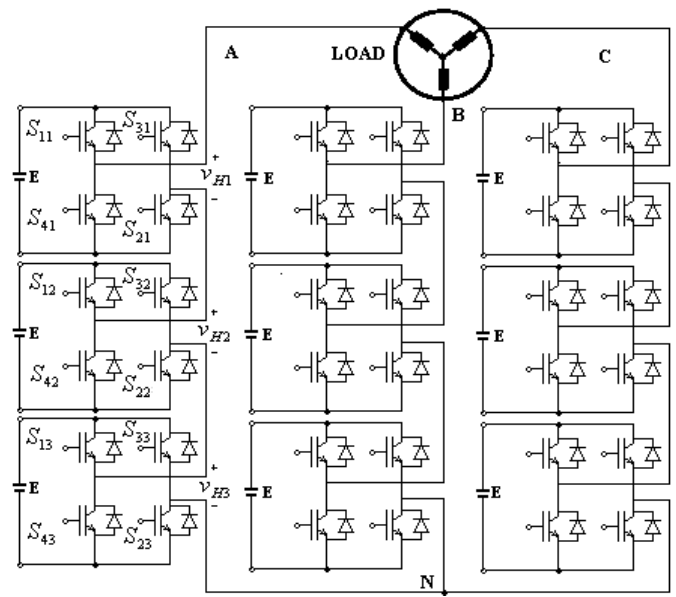
Figure 1. Topology of a cascaded H-bridge (CHB) inverter. Table 1. The outputs corresponding to different output state functions.